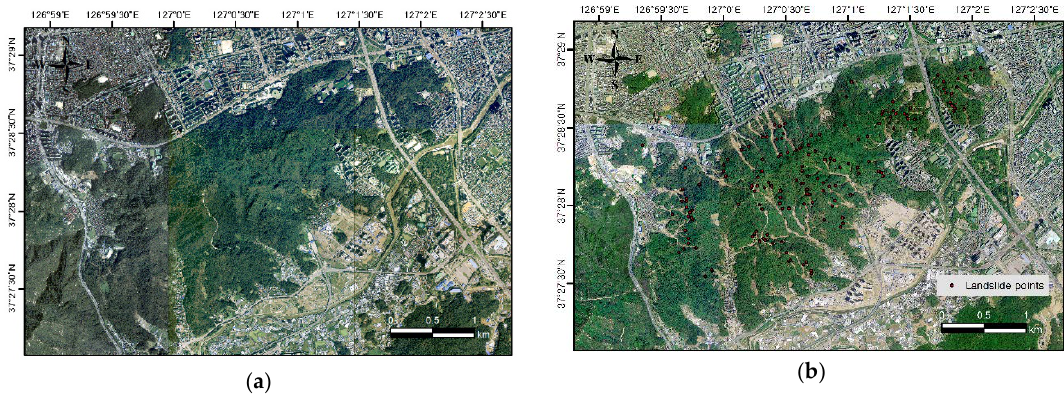
Figure 3. Digital orthoimages of the study area: ( a ) before landslides in 2011; ( b ) after landslides in 2011.